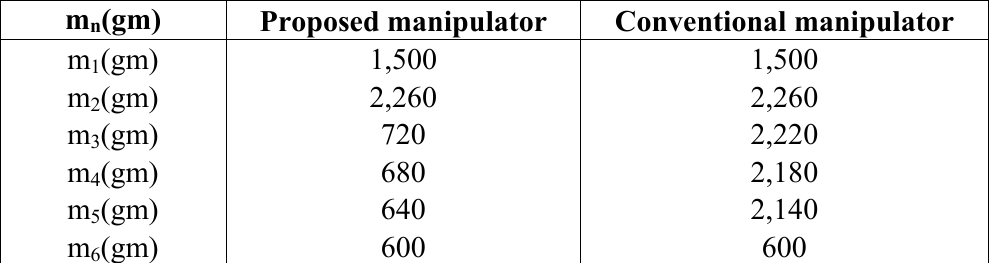
Table 2. The mass of links for both the proposed and conventional